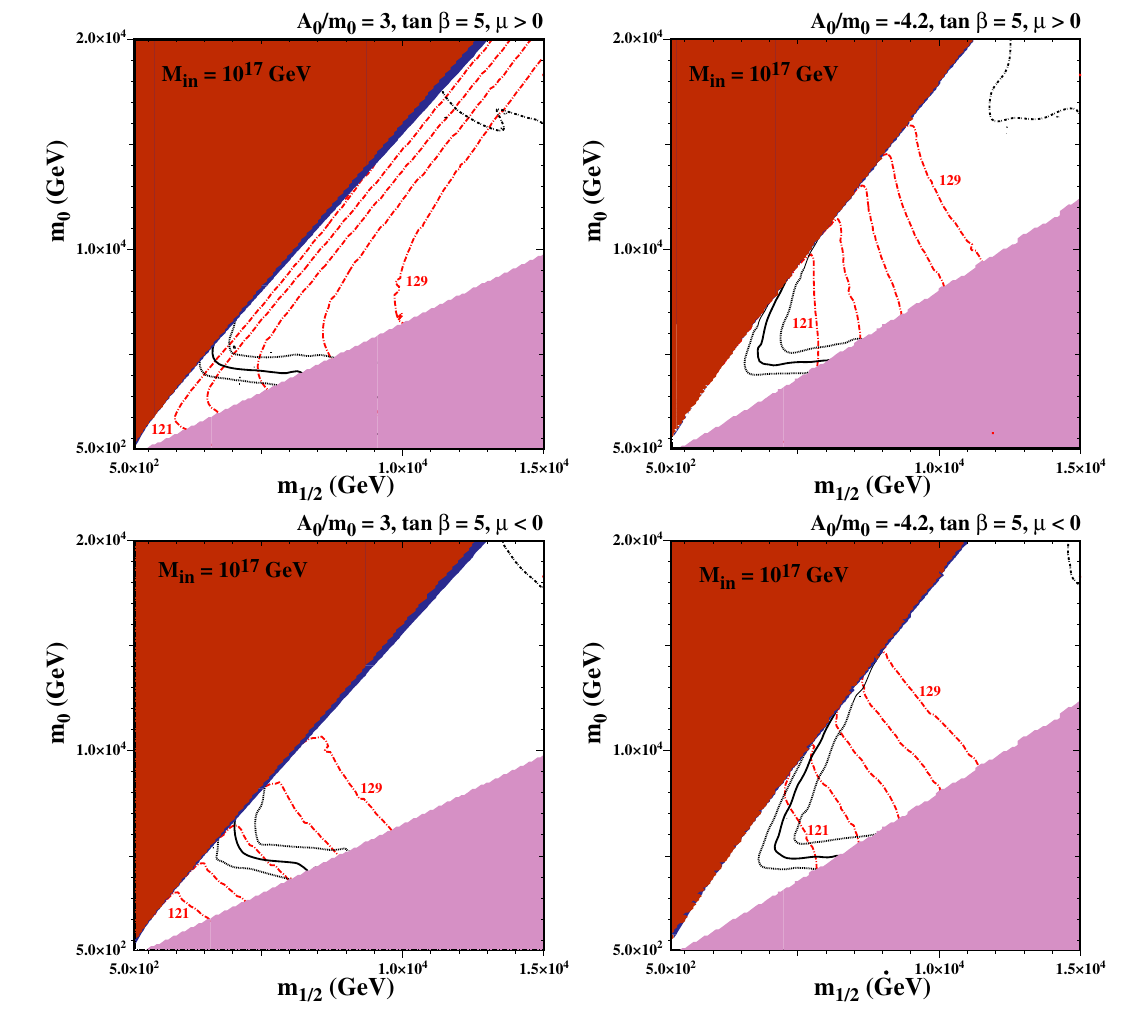
Fig. 13 Some ( m 1 / 2 , m 0 ) planes in the super-GUT model with M in = 10 17 GeV for tan β = 5, μ > 0 (upper panels), μ < 0 (lower panels), A 0 / m 0 = 3 (left panels), A 0 / m 0 = − 4 . 2 (right panels). The black lines are contours of the p → K + ¯ ν lifetime, as calculated varying the